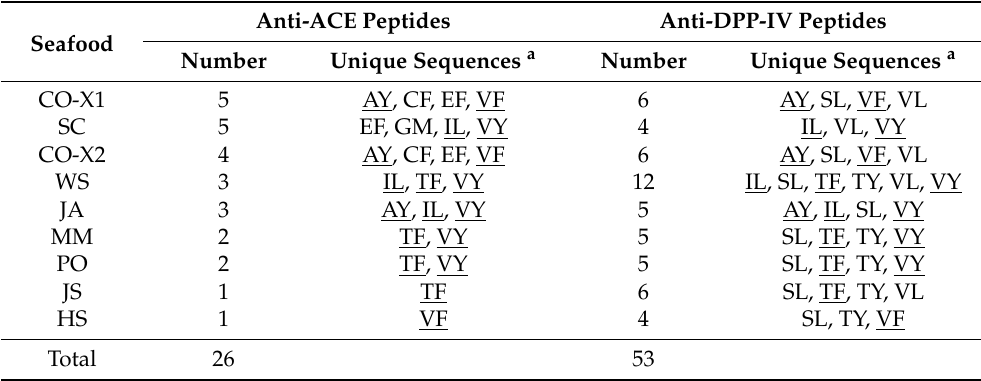
Table 2. The numbers of high-GI-absorption, non-allergenic, and non-toxic peptides with known anti-ACE and anti-DPP-IV